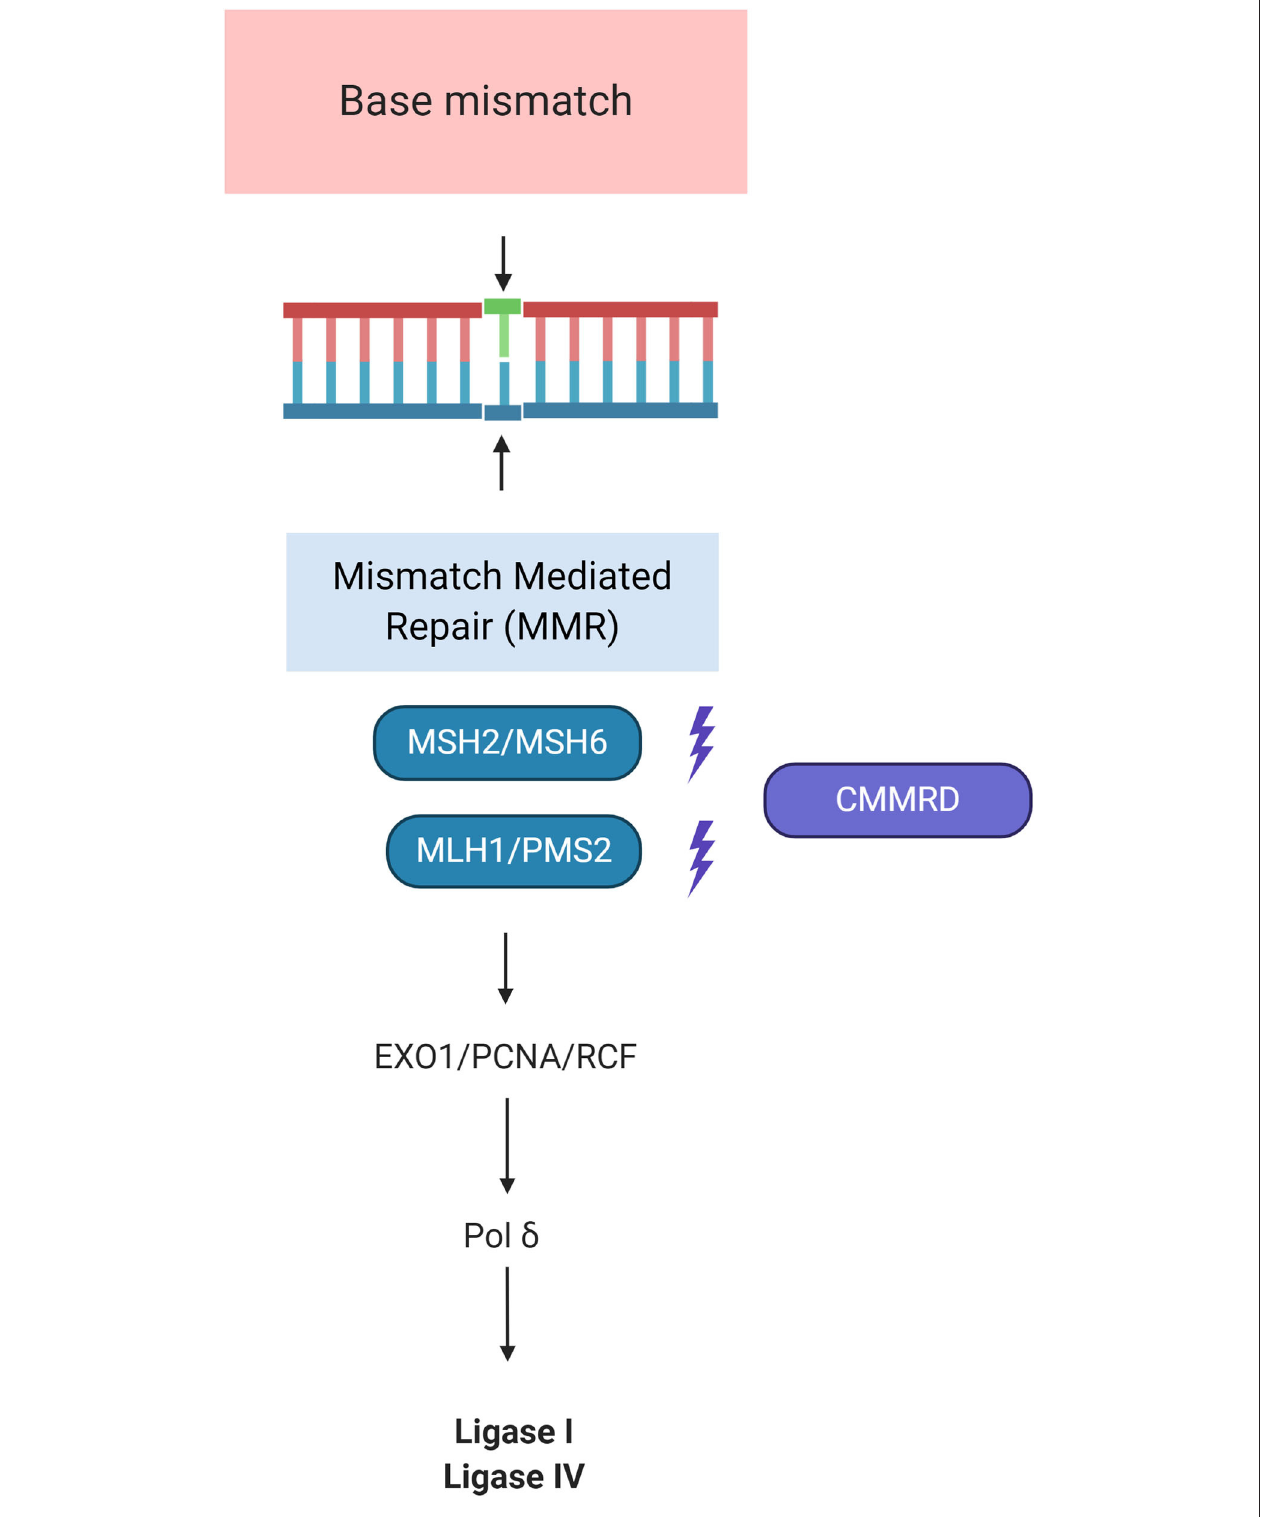
FIGURE 2 | Molecular pathways of Constitutional Mismatch Repair Deficiency Syndrome (CMMRD). MSH2 dimerizes with MSH6 to form the MutS α complex, which is involved in base mismatch repair and short insertion/deletion loops. The formation of the MSH2-MSH6 heterodimer accommodates a second heterodimer of MLH1 and PMS2. This protein complex formed between the 2 sets of heterodimers enables initiation of repair of the mismatch defect by recruiting PCN/EXO1/RCF. RFC is